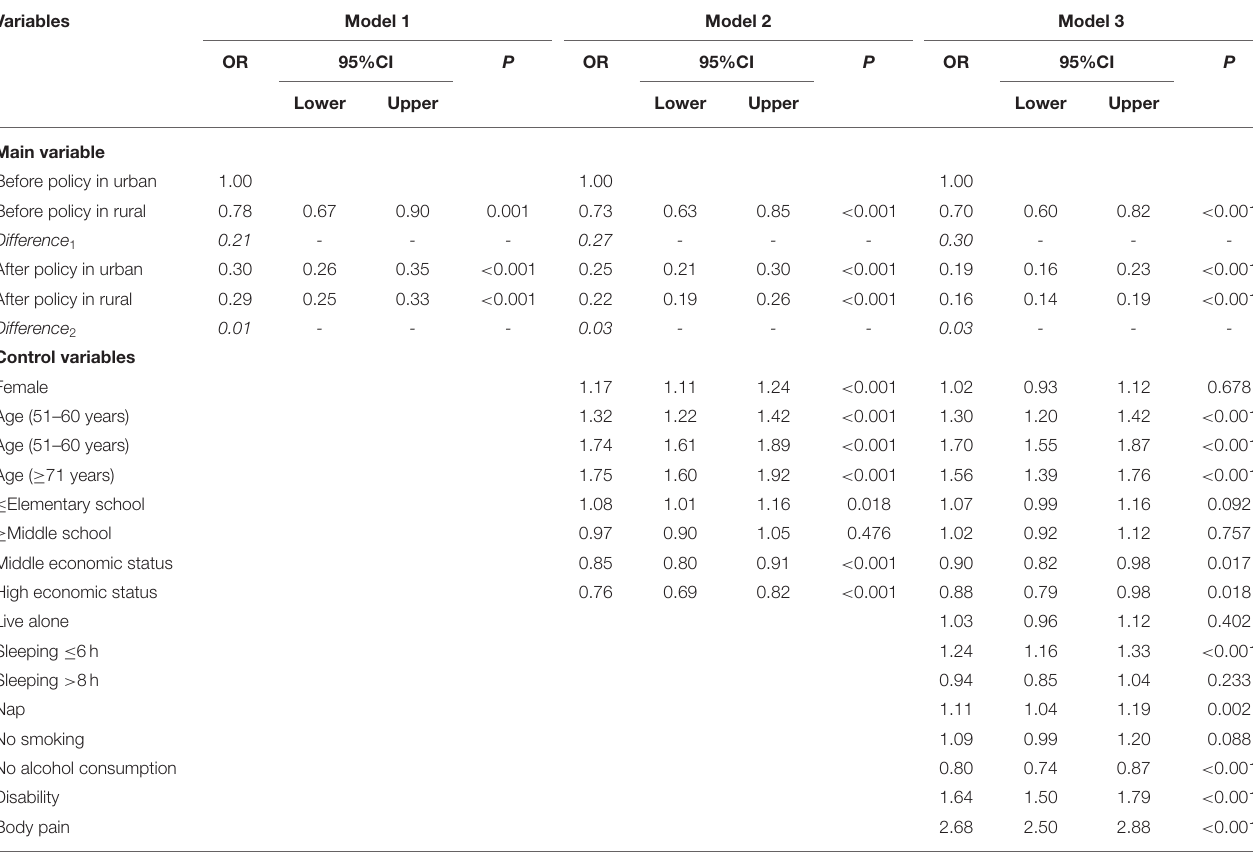
TABLE 5 | Effect of urban and rural residents’ basic medical insurance policy on health outcome ( n = 28,442). Variables Model 1 Model 2 Model 3